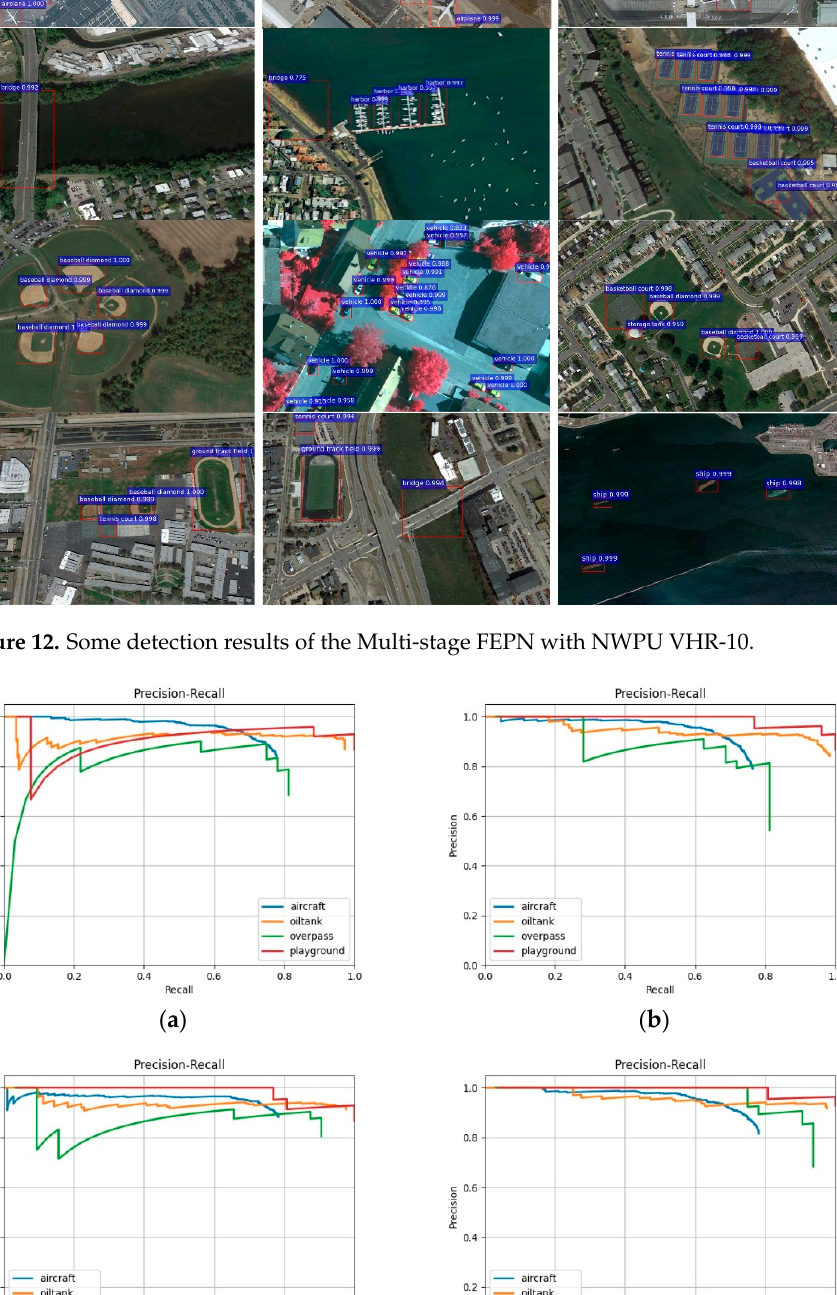
Table 6. The APs for each category and the mAP of different frameworks on RSOD-Dataset.